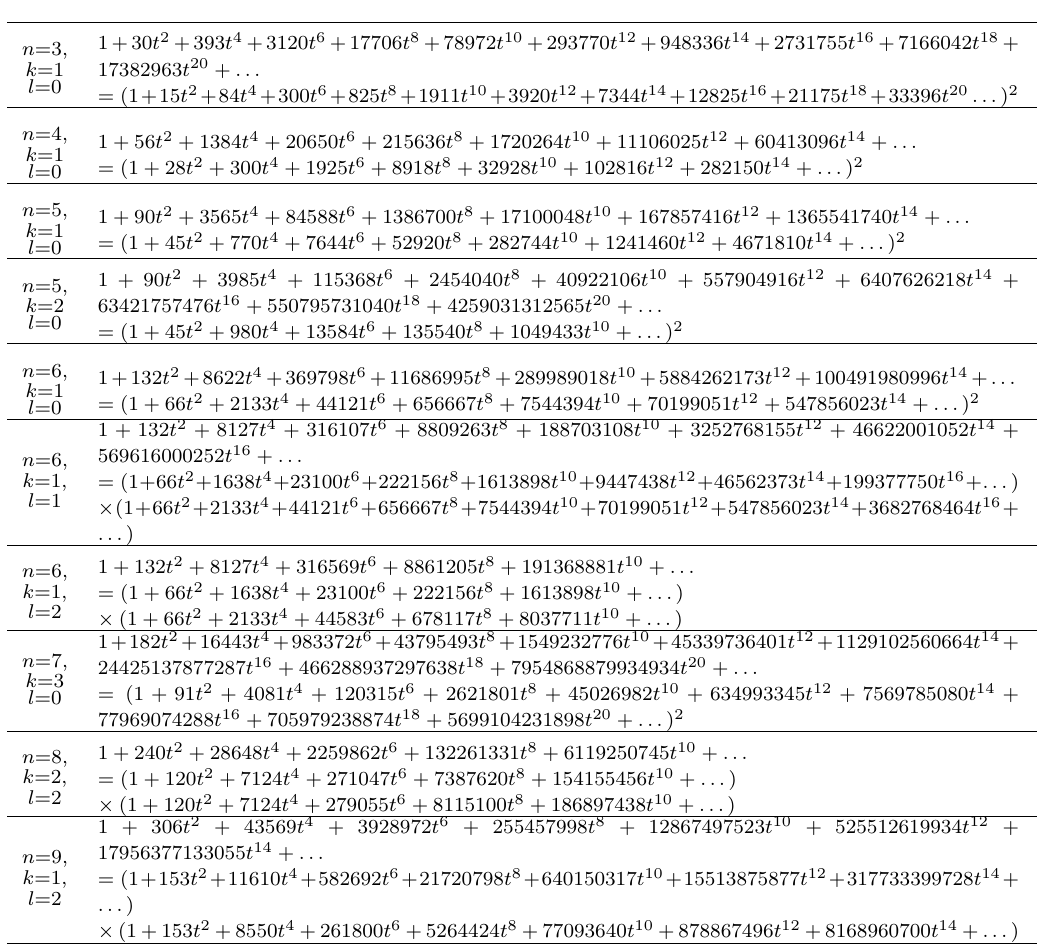
Table 8. Hilbert series results for (2.5). The first line displays the Coulomb branch Hilbert series for (2.5), while the second line displays the factorisation (2.13). Each factor matches the Higgs branch Hilbert series of Sp( k ) or Sp( k + l ) SQCD with N